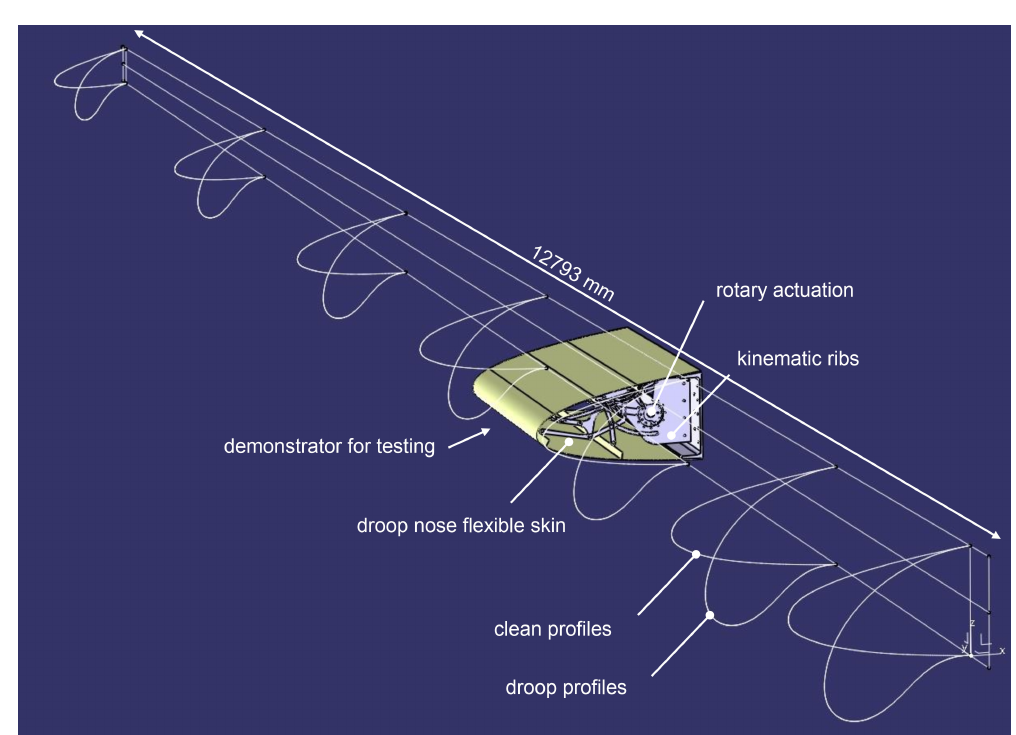
Figure 3. Starboard wing profiles with spanwise position and conceptual design of the droop nose